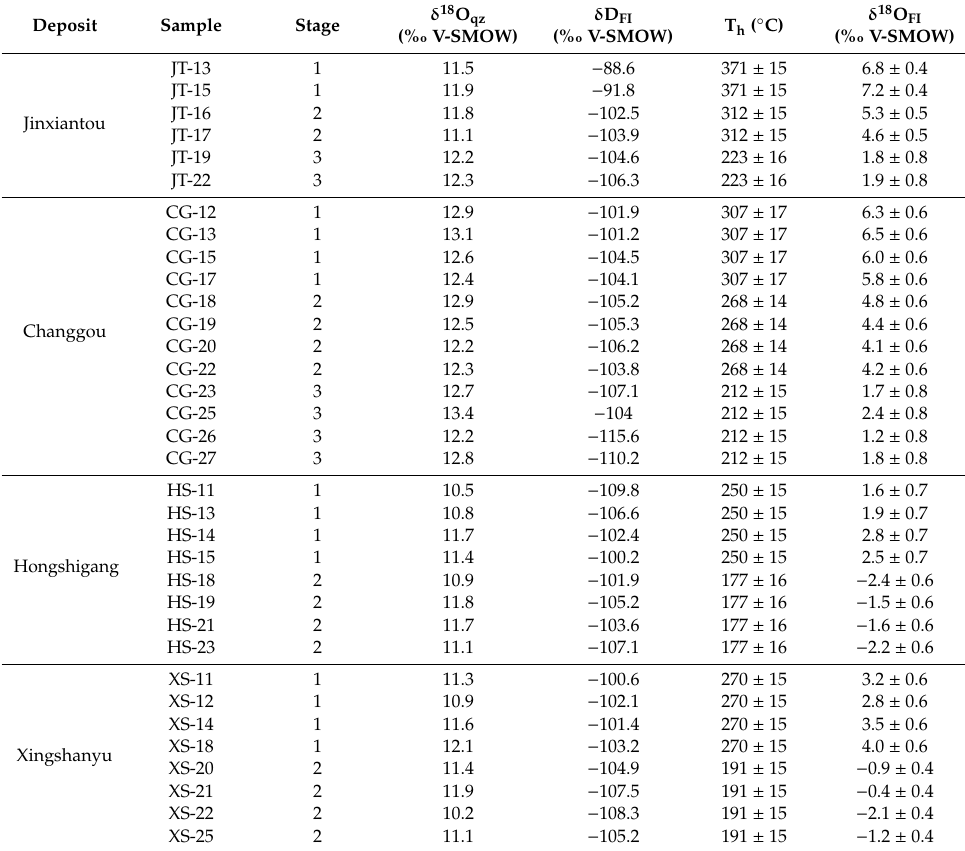
Table 2. Oxygen and hydrogen isotopic data for quartz and fluid inclusion waters associated with various stages of hydrothermal quartz from the Qibaoshan polymetallic ore field. Deposit Sample Stage